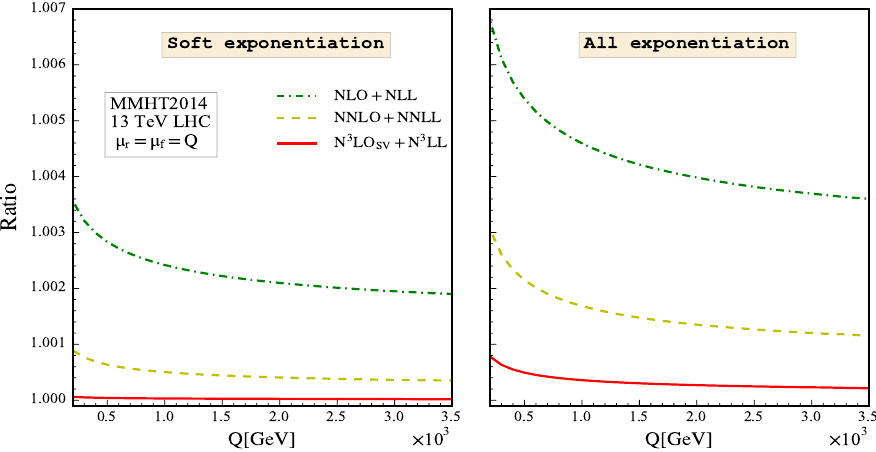
Figure 4 . Comparison between the Soft (left panel) and All exponentiation (right panel) with Standard N approach. Here, the ratio is taken over the Standard N